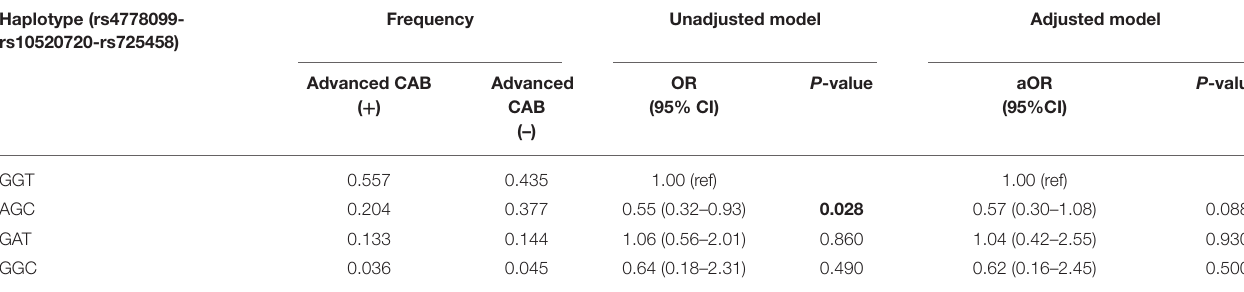
TABLE 4 | Haplotype-based association analysis of cerebral atherosclerosis